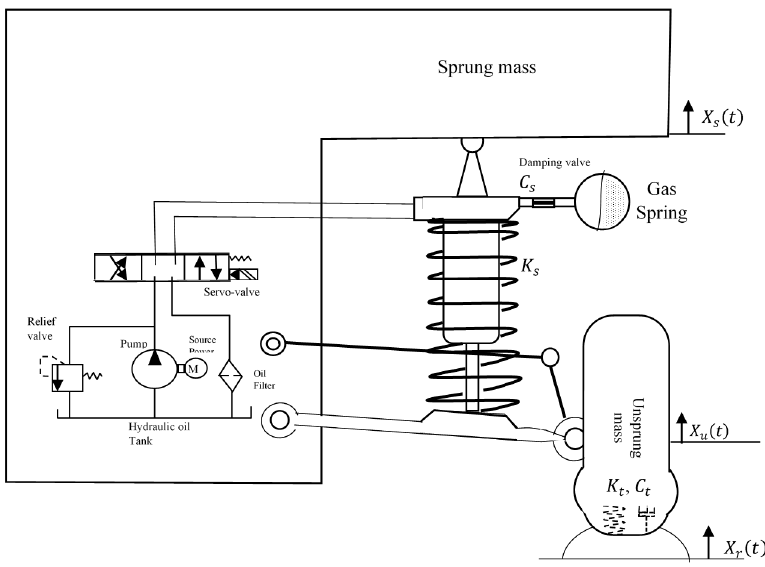
Figure 1. Sketch of a quarter-car active suspension.